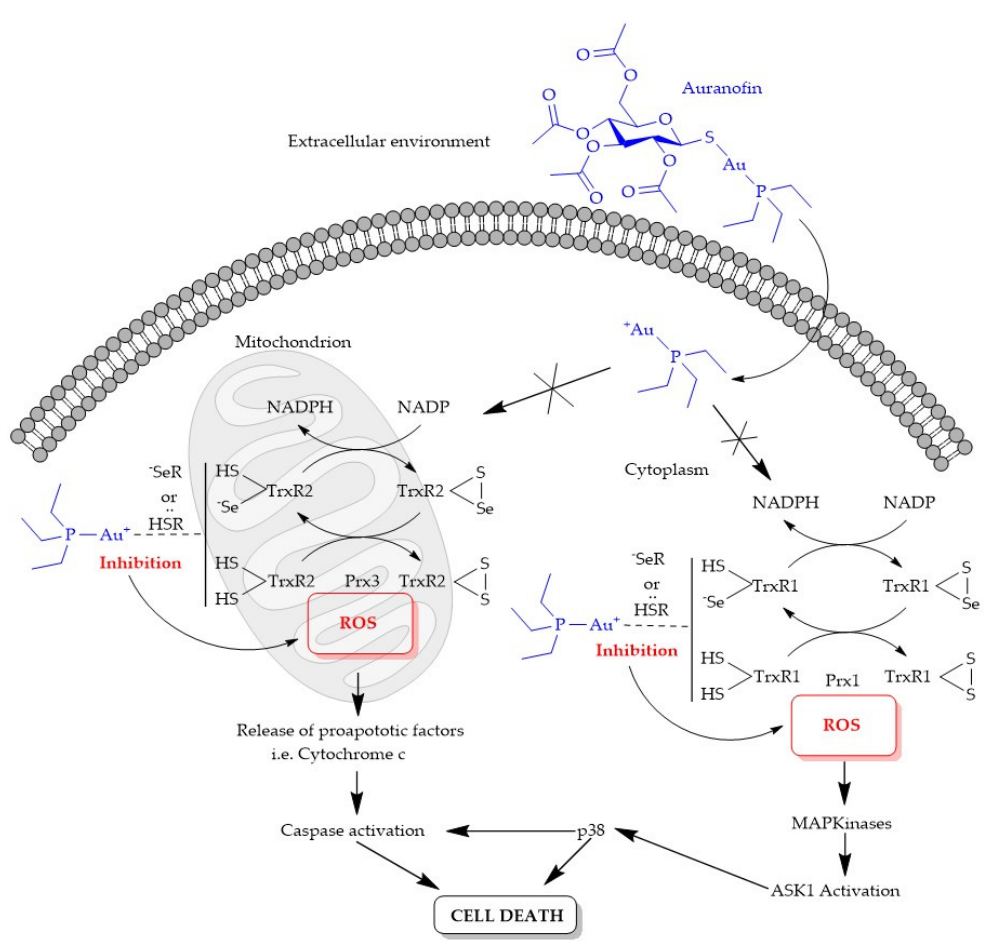
Figure 10. The proposed mechanism of cellular uptake and cytotoxicity of auranofin.